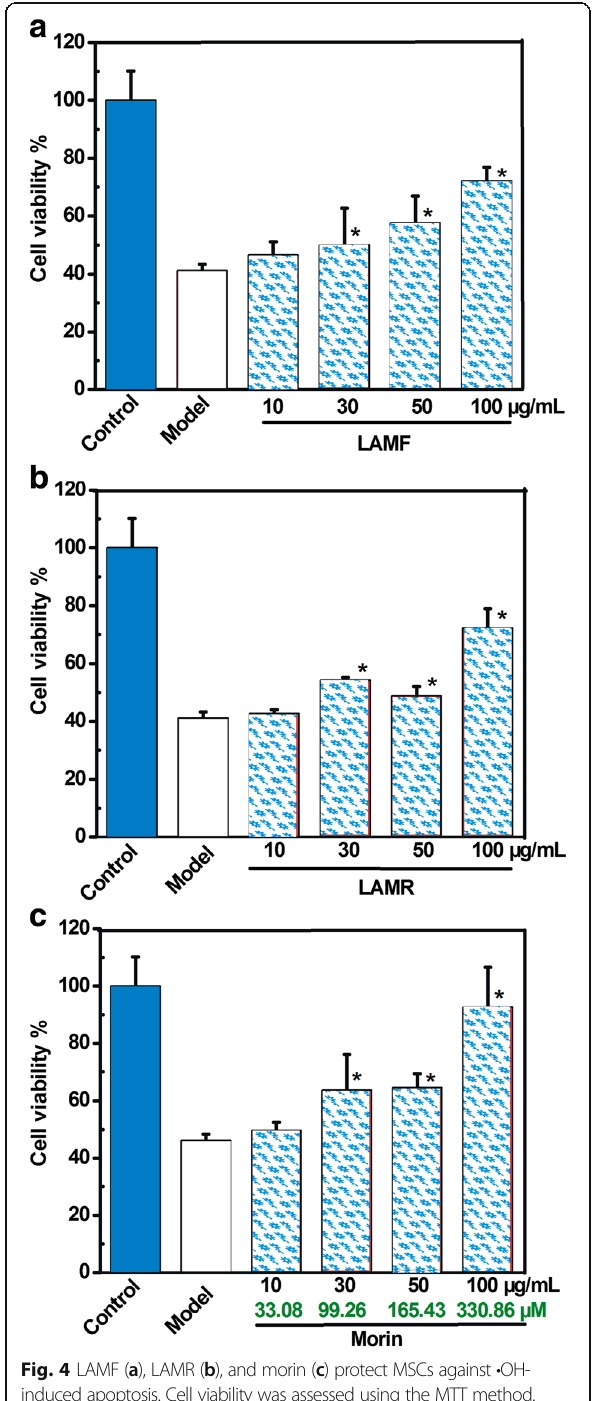
Fig. 4 LAMF ( a ), LAMR ( b ), and morin ( c ) protect MSCs against • OH- induced apoptosis. Cell viability was assessed using the MTT method. Experiments were performed with 3 different batches of cells, and each batch was tested in triplicate. Data are the mean ± SD values. (*) p < 0. 05, compared with MSCs damage following FeCl 2 plus H 2 O 2 . LAMF, Lyophilized aqueous extract of Mori Fructus ; LAMR, lyophilized aqueous extract of Mori